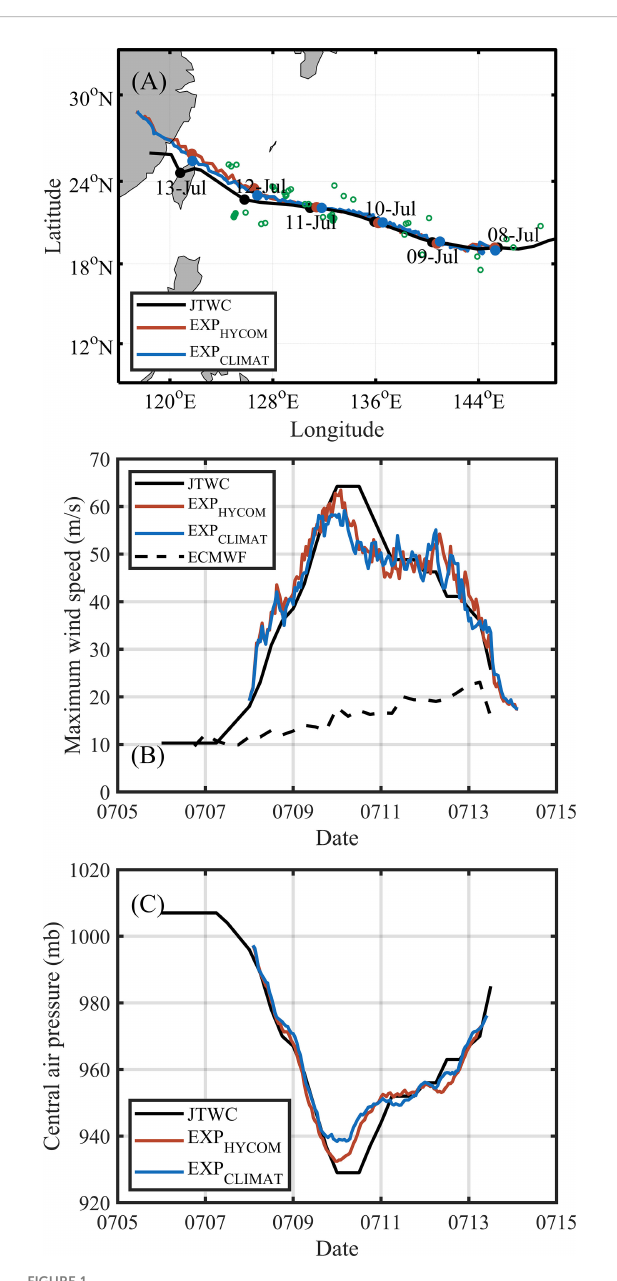
FIGURE 1 Comparisons of the (A) tracks, (B) maximum wind speeds, and (C) central surface air pressures of Typhoon Soulik between the best track data (JTWC) and the simulated results. Green circles are the locations of Argo observations within 200 km of the track from July 7 to July 17. In (B) , the dashed line shows the maximum wind speeds of Typhoon Soulik (2013) obtained from the ECMWF reanalysis